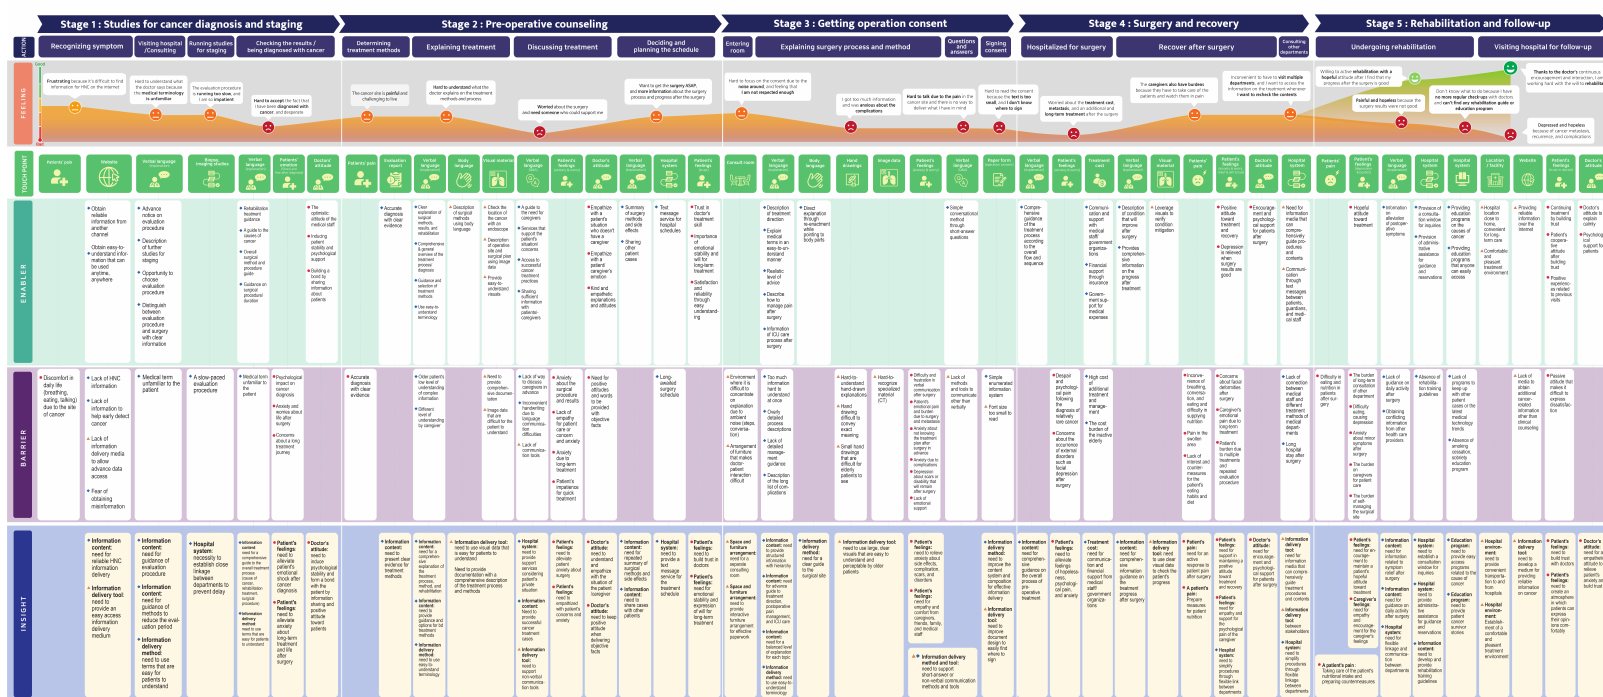
Figure 1. This is a wide figure.